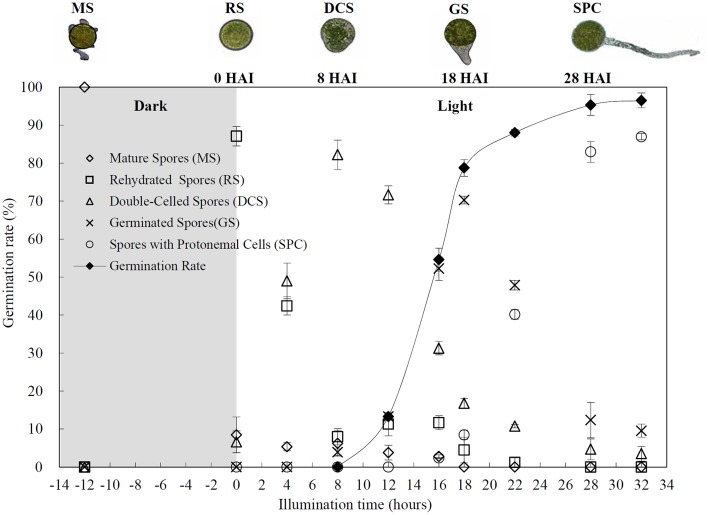
Germination time course of spores from
E. arvense. Mature spores (MS) (open rhombuses) were cultured on Knop's medium. After 12 h dark imbibition, 87% of the rehydrated spores (RS) (open squares) completed rehydration, which were enlarged with an open trilete aperture. Then, spores were cultured under continuous illumination. At 8 h after illumination (HAI), 82% spores completed first mitosis to form double-celled spores (DCS) (open triangles). At 18 HAI, over 70% spores generated rhizoids, which were defined as germinated spores (GS) (crosses). At 32 HAI, more than 87% spores finished the second cell division, which were called spores with protonemal cells (SPC) (open circles). The spore germination rate (filled rhombuses) was increased gradually in this time course, and the maximum germination rate was over 95% at the stage of SPC. Error bar indicates ± standard deviation.